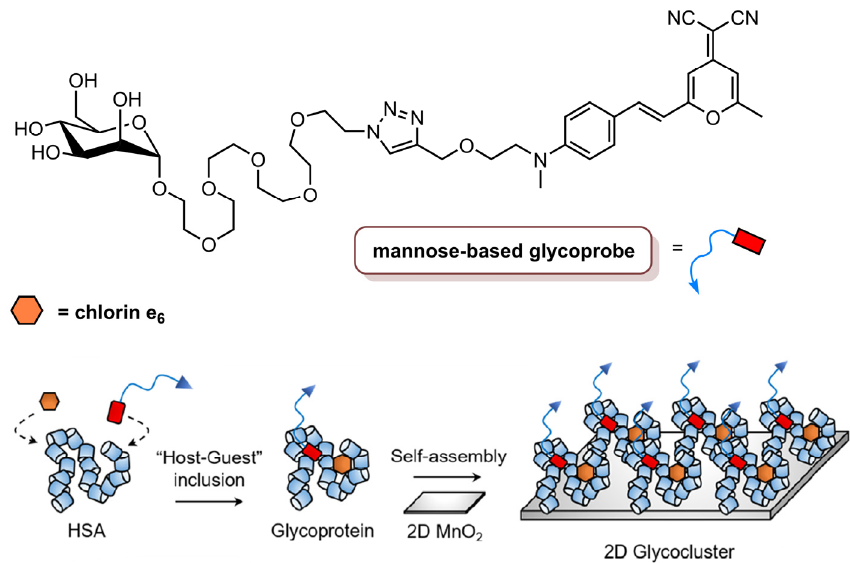
Figure 12. Schematic representation of the inclusion of the glycoprobe and Ce 6 to HSA, resulting in the glycoprotein that was self-assembled with 2D MnO 2 for the formation of 2D glycocluster (reproduced from Reference [84] with permission from the American Chemical Society).